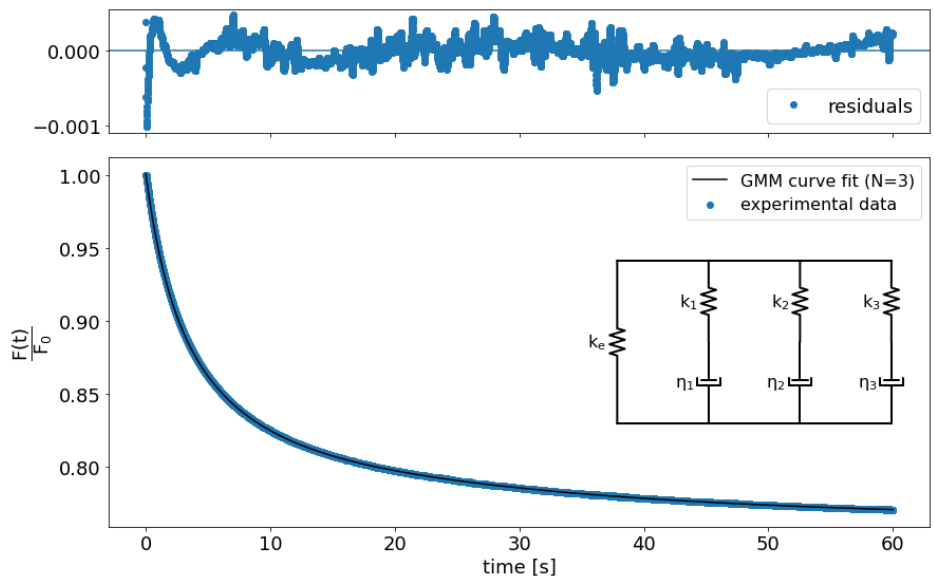
Figure B1. Third order GMM fitting (N=3) to a relaxation curve of a 4 kPa PAM hydrogel immersed in ddH 2 O + 0.1% Extran. The superior graph shows the residues of the fitting. Experimental data is normalized before adjusting with a GMM